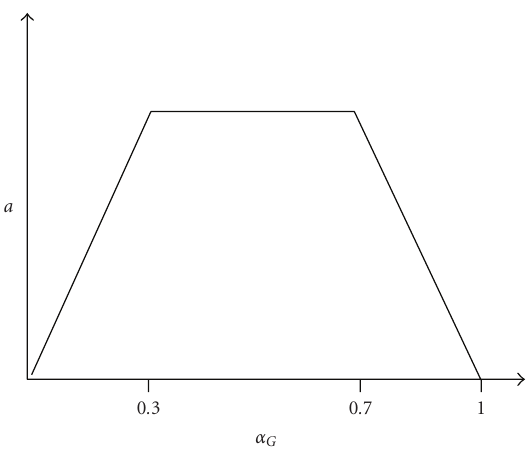
Figure 10: The continuous phase density as a function of the gas void fraction.